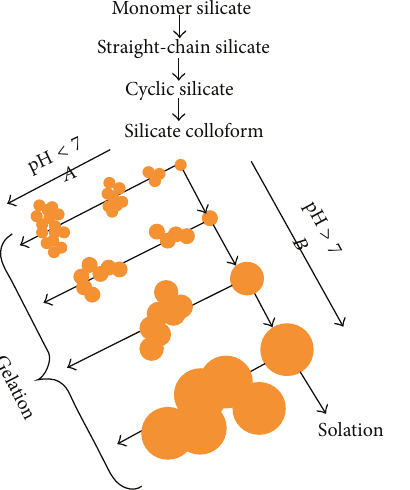
Figure 2: Growth of colloidal particle and gelatinization [22].